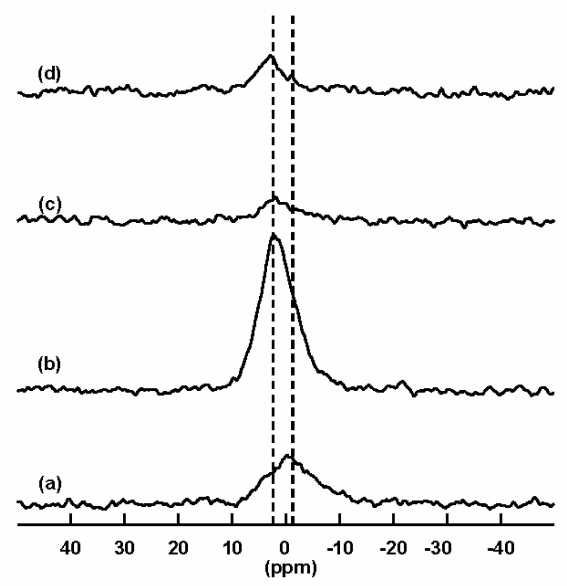
Figure 5. The 31 P High Power Decoupling-Magic Angle Spinning (HPDEC-MAS) NMR spectra of ( a ) PETRO; ( b ) GEODIA; ( c ) APHRO; and ( d ) LAOCO. For all spectra, the recycling delay was 10 s at 30 ˝ pulse and the number of scans was